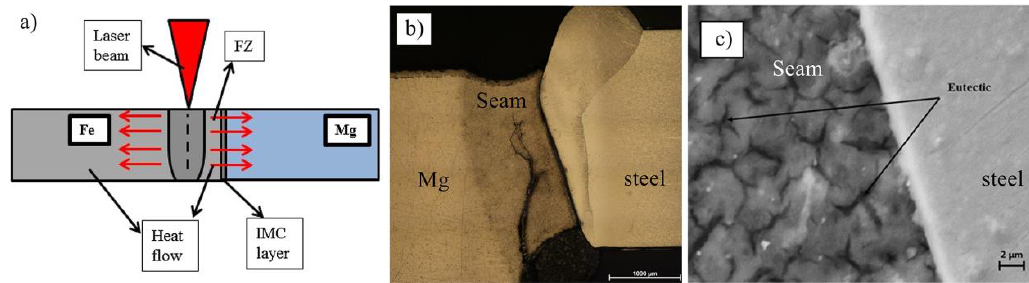
Figure 10. Laser offset welding of the AZ31/316 joint with 0.4 mm offset [35] ( a ) schematic diagram; ( b ) cross section of joint; ( c ) the microstructure near the Mg/steel interface.